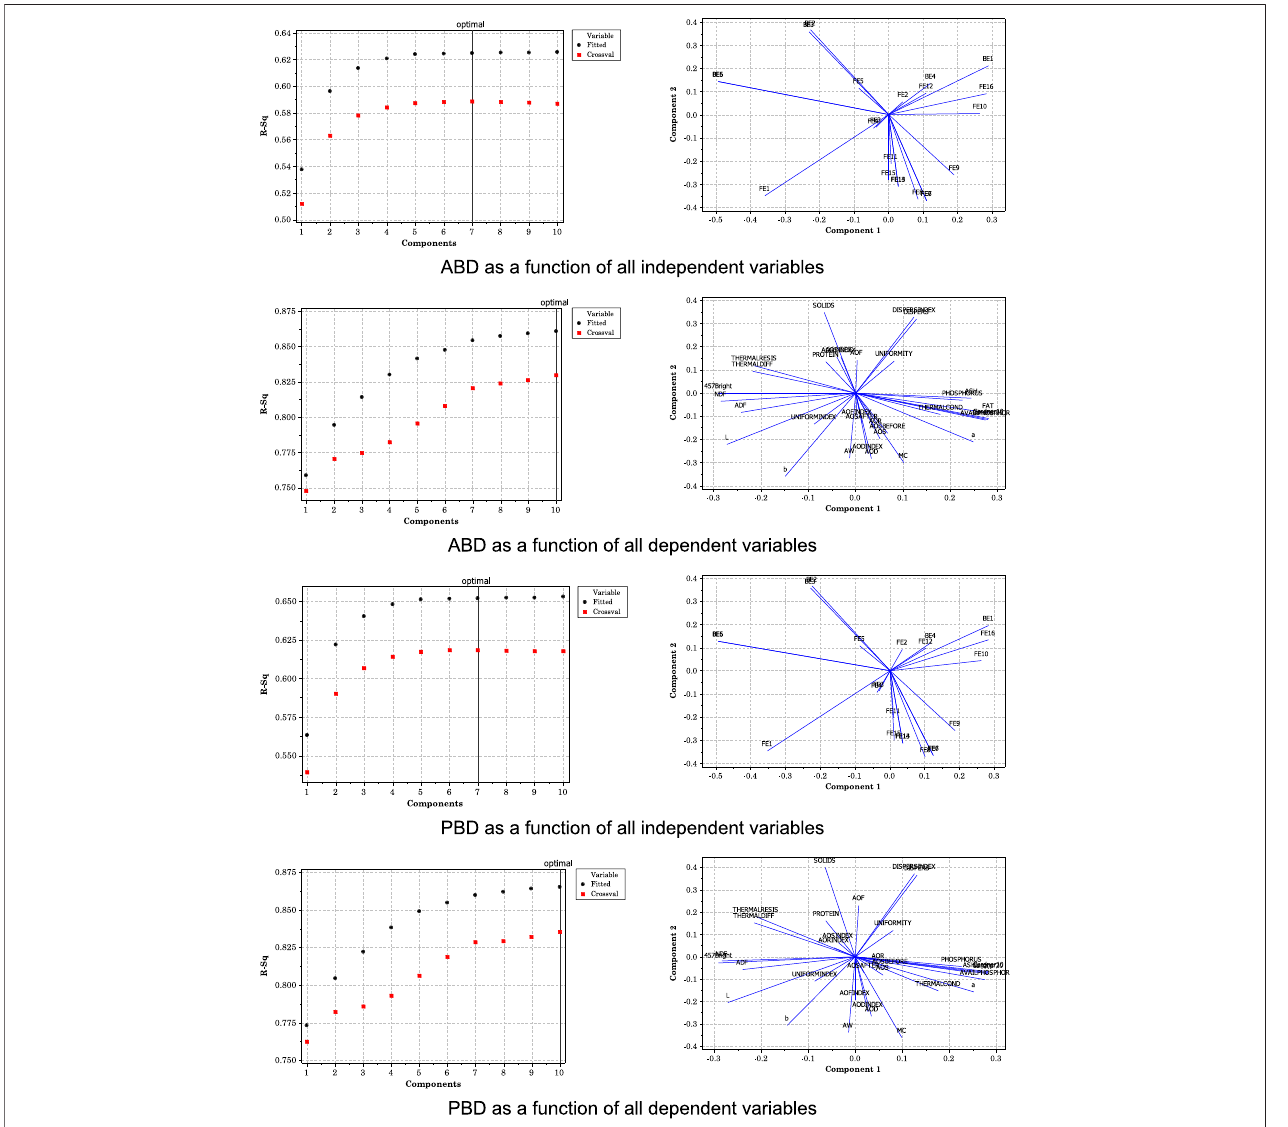
FIGURE 7 | Model selection and loading plots for ABD and PBD from PLS